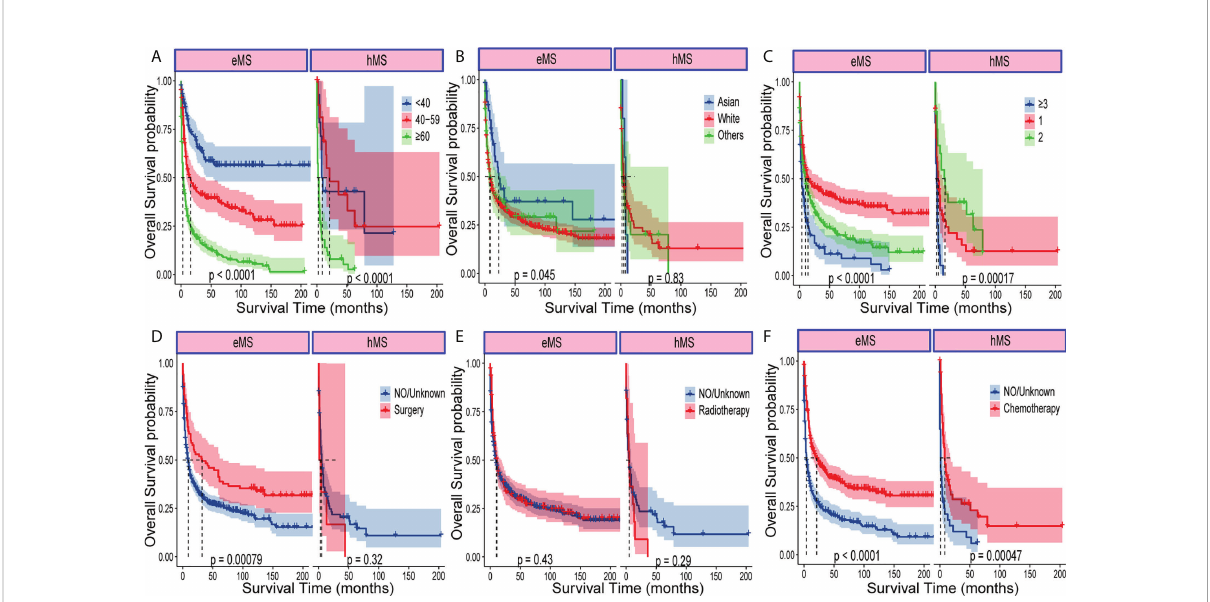
FIGURE 3 Kaplan – Meier analysis of OS in eMS and hMS, respectively. Kaplan – Meier survival curves of OS for patients with eMS or hMS strati fi ed by age (A) , race (B) , number of tumors (C) , surgery (D) , radiotherapy (E) and chemotherapy (F)